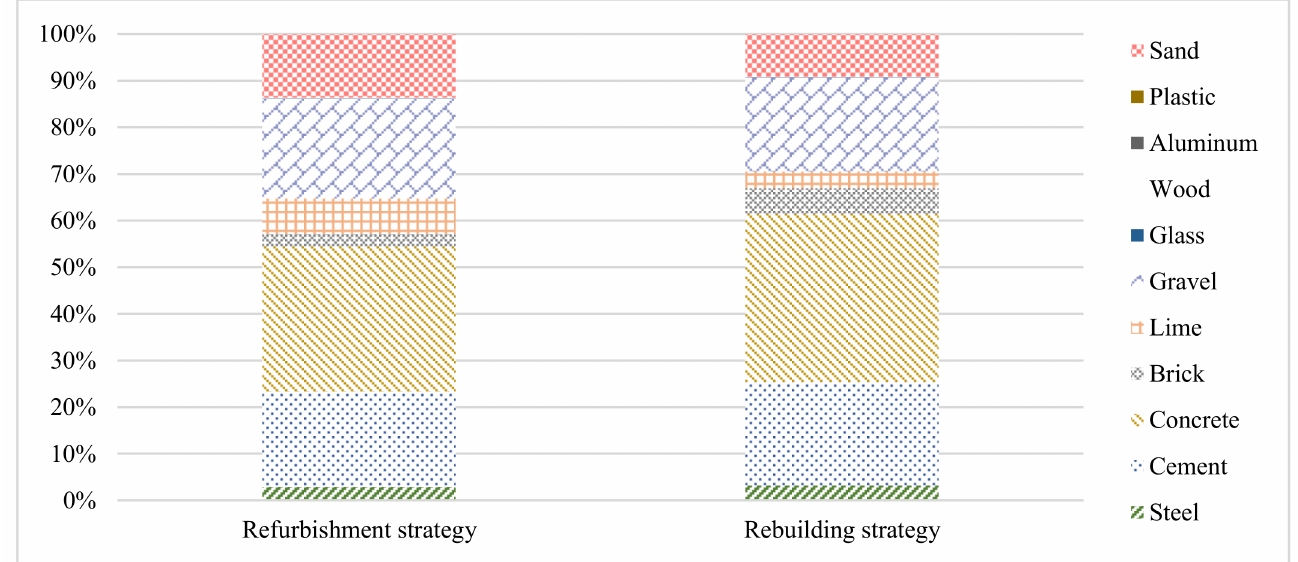
Figure 5. The weight of the building materials in the construction